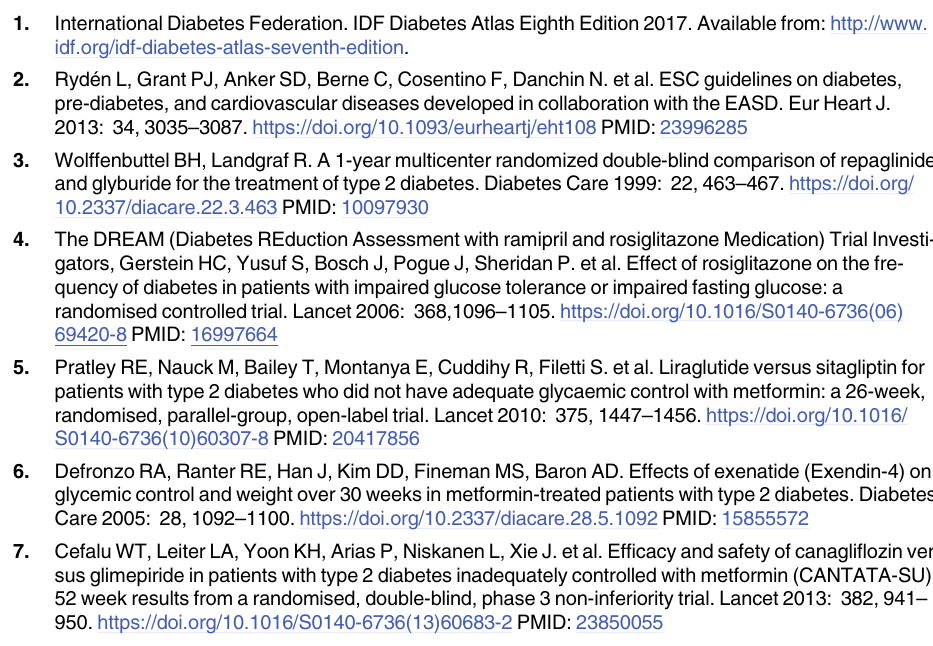
S1 Table. Characteristics of new users of dipeptidyl peptidase-4 inhibitors and biguanides younger than 65 years. S2 Table. Characteristics of new users of dipeptidyl peptidase-4 inhibitors and biguanides 65 years and